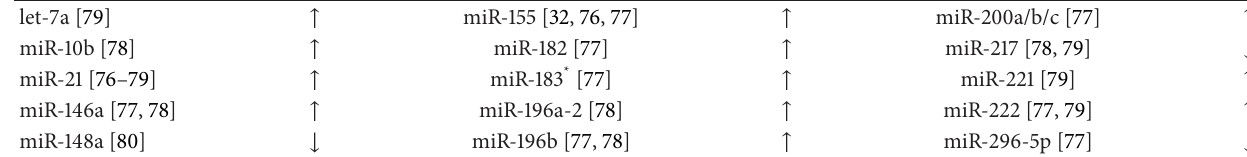
Table 2: miRNAs whose expression increase ( ↑ ) or decrease ( ↓ ) with increasing PanIN